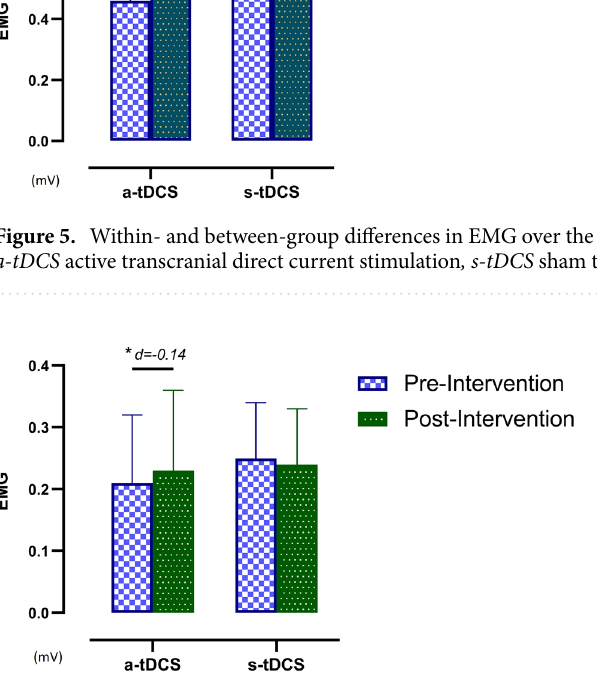
Figure 6. Within-group differences in EMG over the rectus femoris. EMG electromyography, a‑tDCS active transcranial direct current stimulation , s‑tDCS sham transcranial direct current